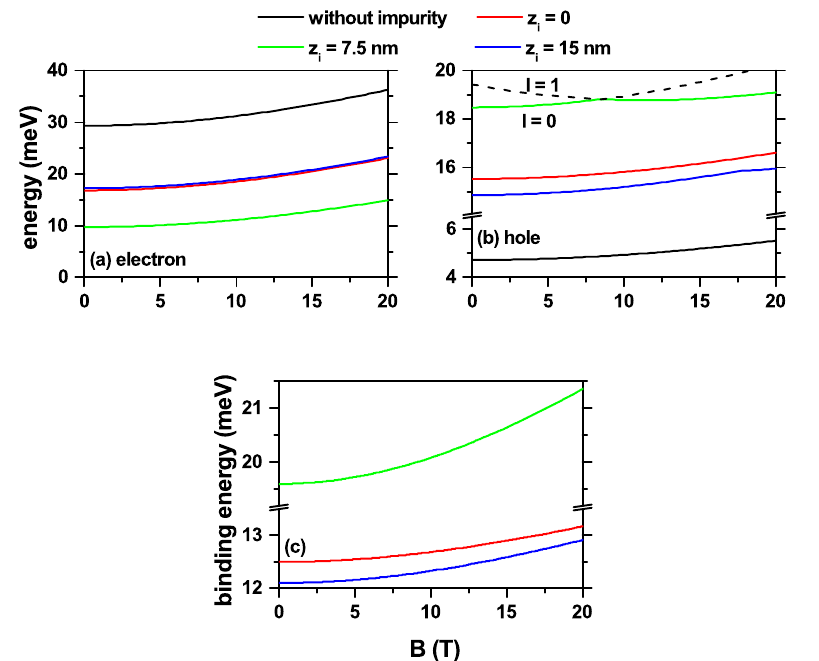
Figure 3. The ground state level for a confined electron/hole ( a )/( b ) in a truncated conical-shaped GaAs-Al 0.3 Ga 0.7 As quantum dot as a function of the vertically applied magnetic field and the corresponding binding energy ( c ). Calculations are for R 1 = 10nm, R 2 = 20nm, h = 15nm, with and without impurity effects according to the color code. Three impurity positions were considered: z i = 0, 7.5nm, and